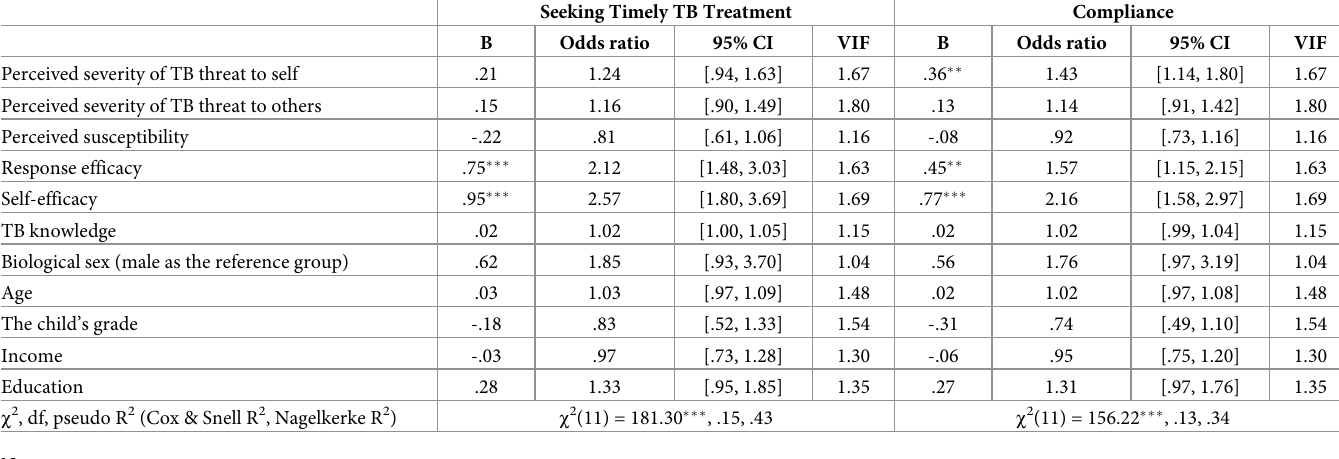
Table 2. The effect of TB-related risk perception and efficacy appraisal on Chinese parents’ decisions about TB treatment; B, odds ratio and 95% confidence